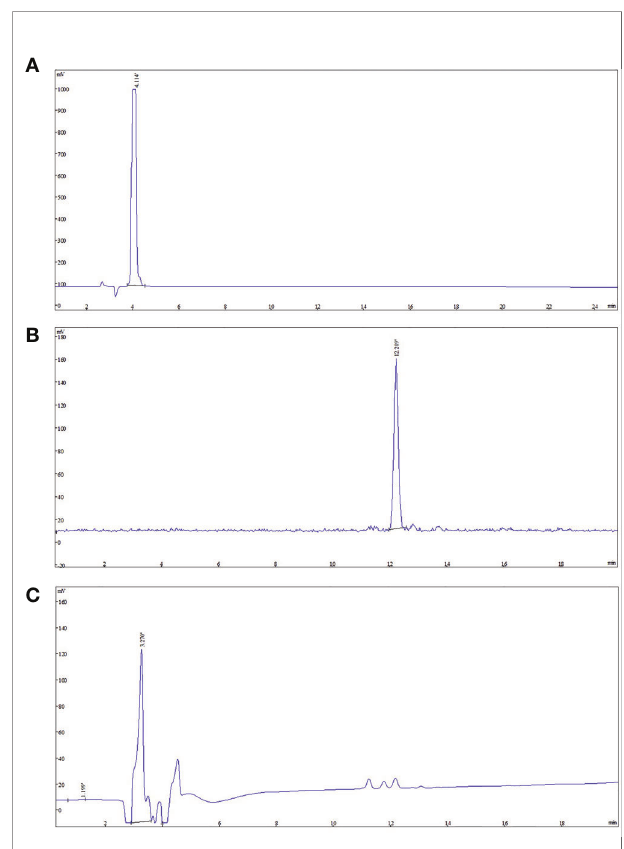
FIGURE 3 | The analytic HPLC chromatogram of puri fi ed [ 18 F]AlF-NOTA- FAPI-04, UV absorbance at 220 nm. The UV absorbance and radioactive signals were both transformed into electrical signals. (A) UV absorbance of NOTA-FAPI-04 precursor. (B) The chromatogram of [ 18 F]AlF-NOTA-FAPI-04 measured by radioactive detector. (C) The chromatogram of [ 18 F]AlF-NOTA- FAPI-04 measured by UV